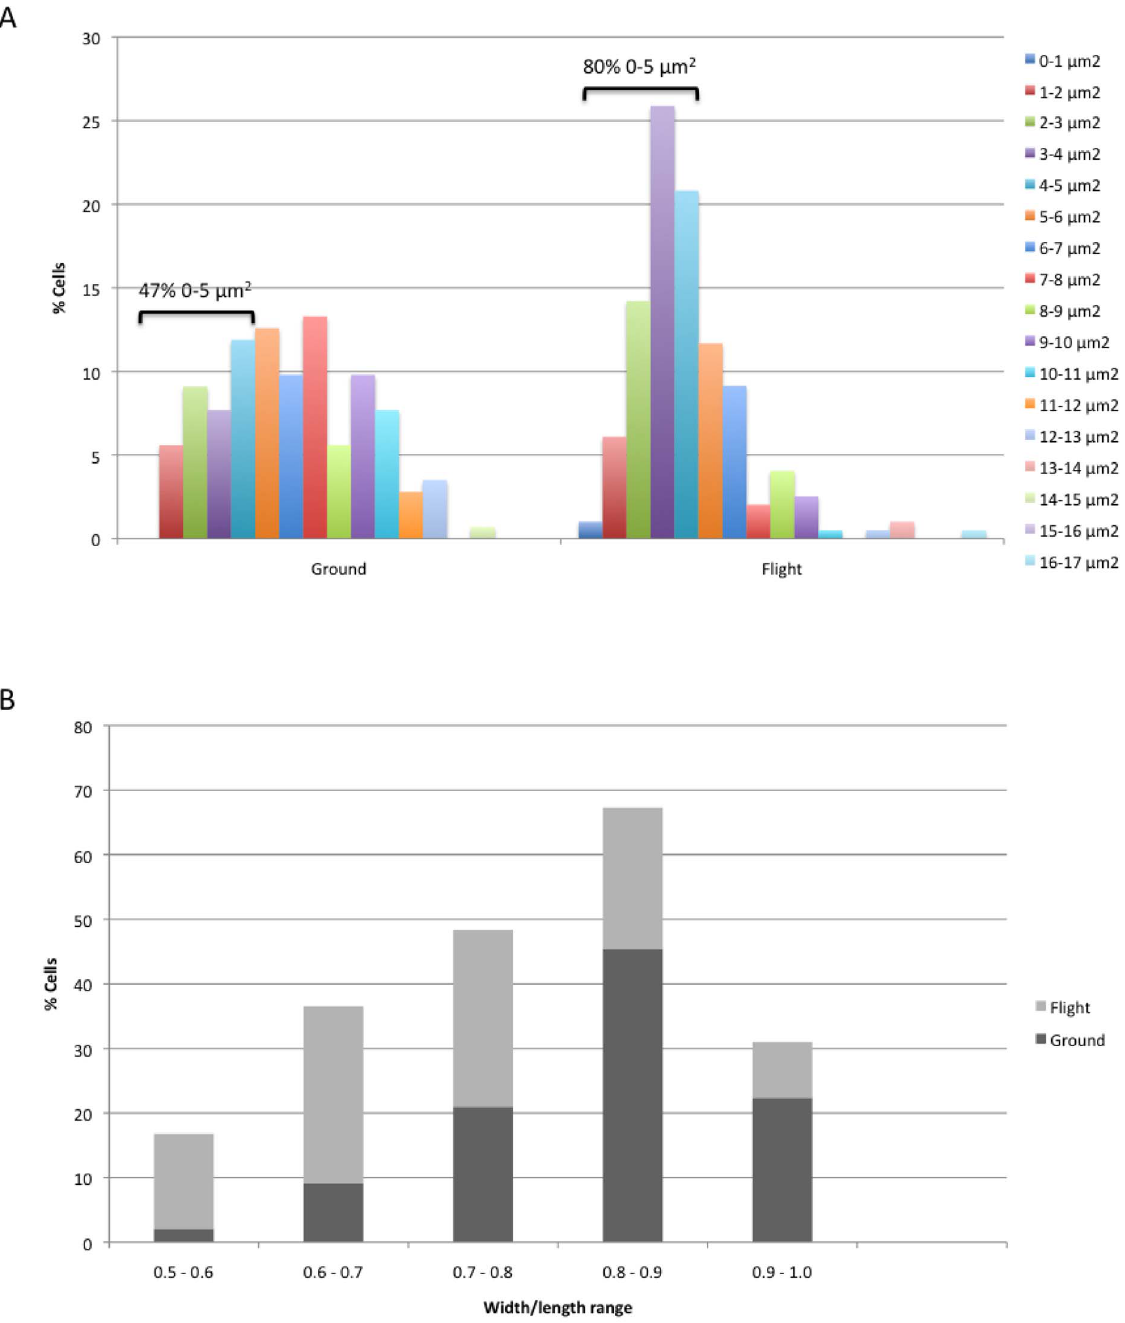
Figure 5. Measurement of cell size and shape of C.albicans spaceflight and ground control cultures. (A) Surface area of spaceflight and ground cells, organized as percentage of cells per size range (1 m m increments). The percentages for ground and flight cultured C. albicans with a surface area between 0 and 5 m m are indicated. (B) Width-to-length ratio of spaceflight and ground cells, organized as percentage of cells per width- to-length range (0.1 increments). Results were obtained based on surface area and width-to-length determination of 143 ground control cells and 197 spaceflight-cultured cells. doi:10.1371/journal.pone.0080677.g005 observed self-aggregative phenotype could be reflective of biofilms. colonization by yeast-form, spherical cells, (ii) microcolony formation on the attached surface by yeast-form cells, (iii) growth of pseudohyphae and hyphae in concert with synthesis of extracellular matrix, and (iv) dispersal of yeast-form cells to initiate biofilm formation off-site [53,54,81]. Microcolony forma- tion on abiotic surfaces (structurally similar to flocculation) is